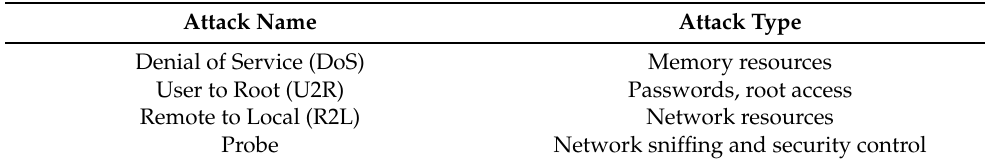
Table 1. Attacks in the NSL-KDD dataset and their impact.